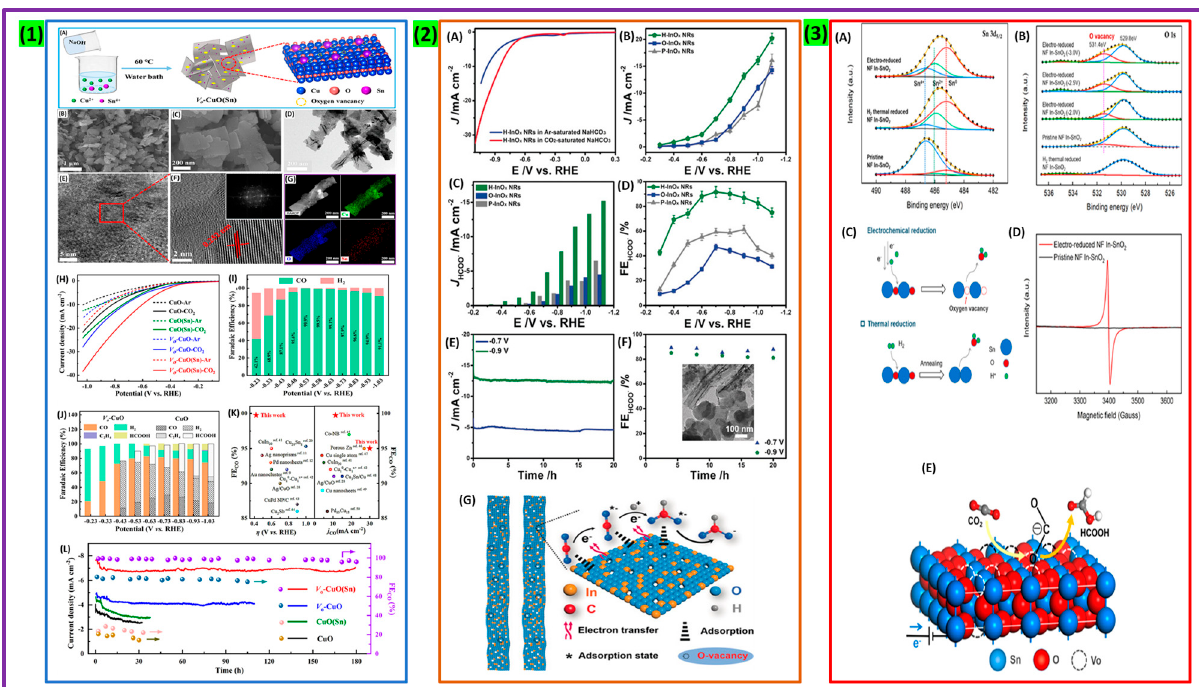
Figure 8. ( 1 ) Schematic diagram of the synthesis of V o -CuO(Sn) ( A ); low-magnification ( B ) and high-magnification ( C ) SEM images of V o -CuO(Sn) nanosheets. Representative ( D ) low-resolution and ( E , F ) high-resolution TEM image images of V o -CuO(Sn) nanosheets. ( G ) The EDS mapping of as-prepared V o -CuO(Sn) nanosheets. Comparison of LSV curves ( H ) of CO 2 -RR FE% for V o -CuO(Sn) ( I ) and V o -CuO, CuO electrodes ( J ). The FE and partial current density of V o -CuO(Sn) compared with other CO 2 -to-CO catalysts ( K ), and the stability measurement of V o -CuO(Sn), V o -CuO, CuO(Sn), and CuO samples ( L ) [165] (copyright: American Chemical Society, 2022). ( 2 ) Linear sweep voltam- mogram curves of H-InO x NRs ( A ); total current densities ( B ); formate partial current densities ( C ); potential-dependent formate FEs of the P-InO x NRs, O-InO x NRs, and H-InO x NRs ( D ); prolonged stability ( E ); formate FEs of the H-InO x NRs ( F ); and amorphous InO x nanoribbons (NRs) with differ- ent concentrations of oxygen vacancies applied as CO 2 electroreduction (CO 2 -RR) catalysts ( G ) [166] (copyright: John Wiley and Sons, 2019). ( 3 ) Evidence of V o . Sn3d5/2 XPS spectra of electro-reduced, thermal-reduced, and pristine NF In–SnO 2 ( A ); corresponding O1s XPS spectra ( B ); schematics of V o decoration through pre-electro reduction ( C ); EPR spectra of pre-electro-reduced and pristine NF In–SnO 2 ( D ); and schematics of CO 2 -to-formate catalysis process at V o sites ( E ) [167] (copyright: American Chemical Society,